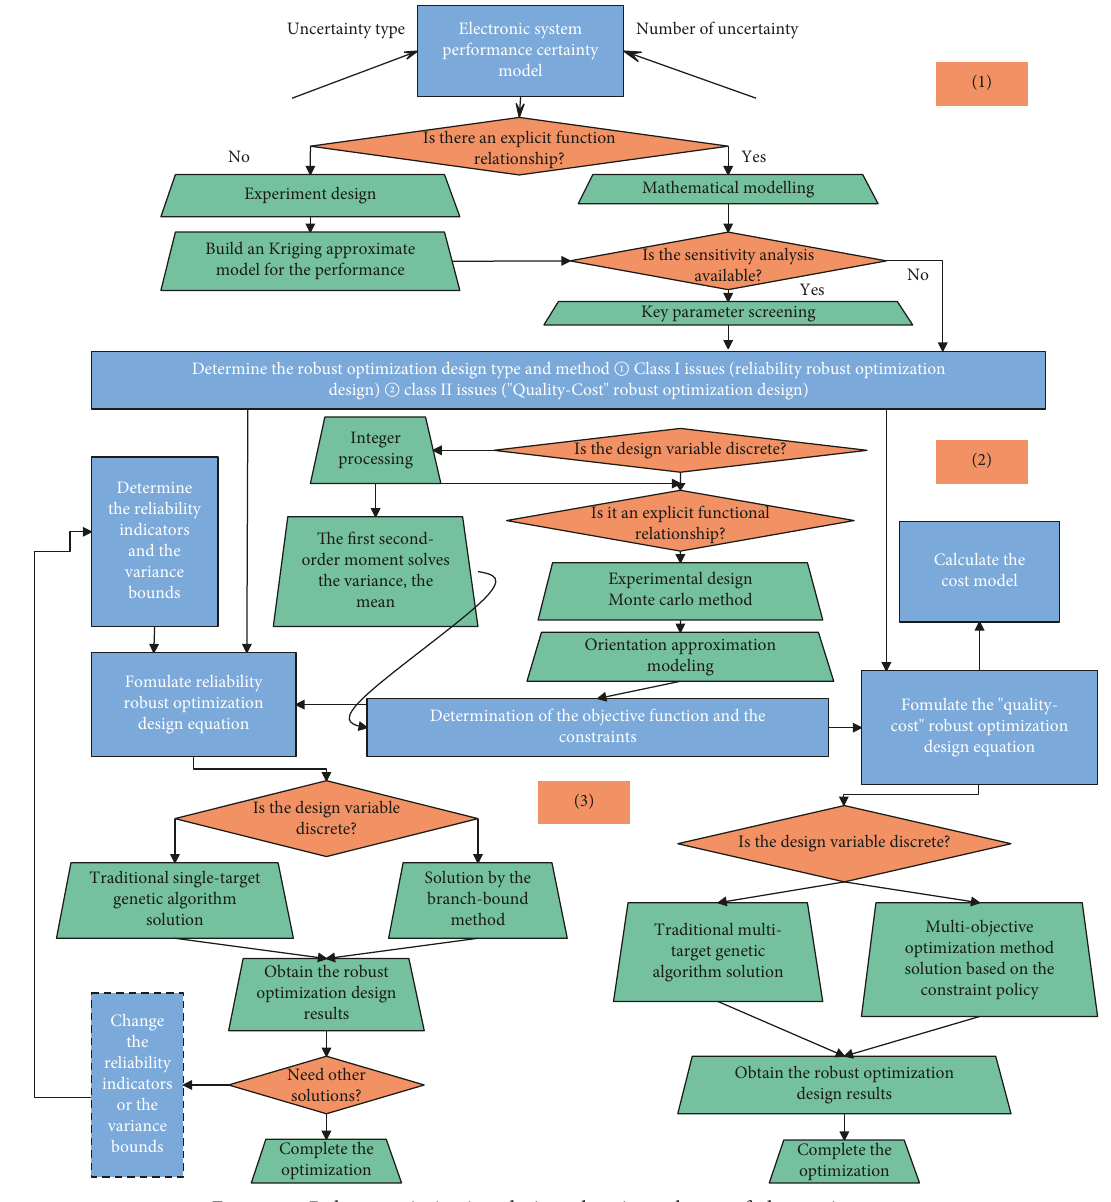
Figure 7: Robust optimization design planning scheme of electronic